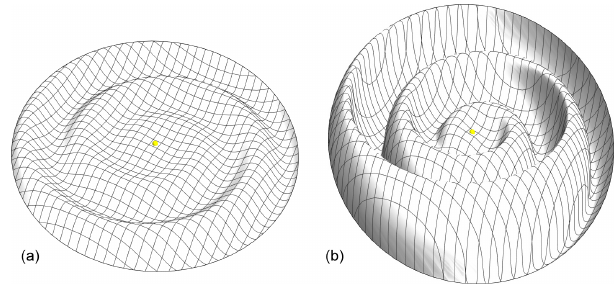
Figure 5. Shape of the “ballerina skirt” model of the heliocentric current sheet defined by cos θ ∗ = cos θ . Topology at t = 0 and for θ t0 = 5 ◦ (a) and θ t0 = 30 ◦ (b)